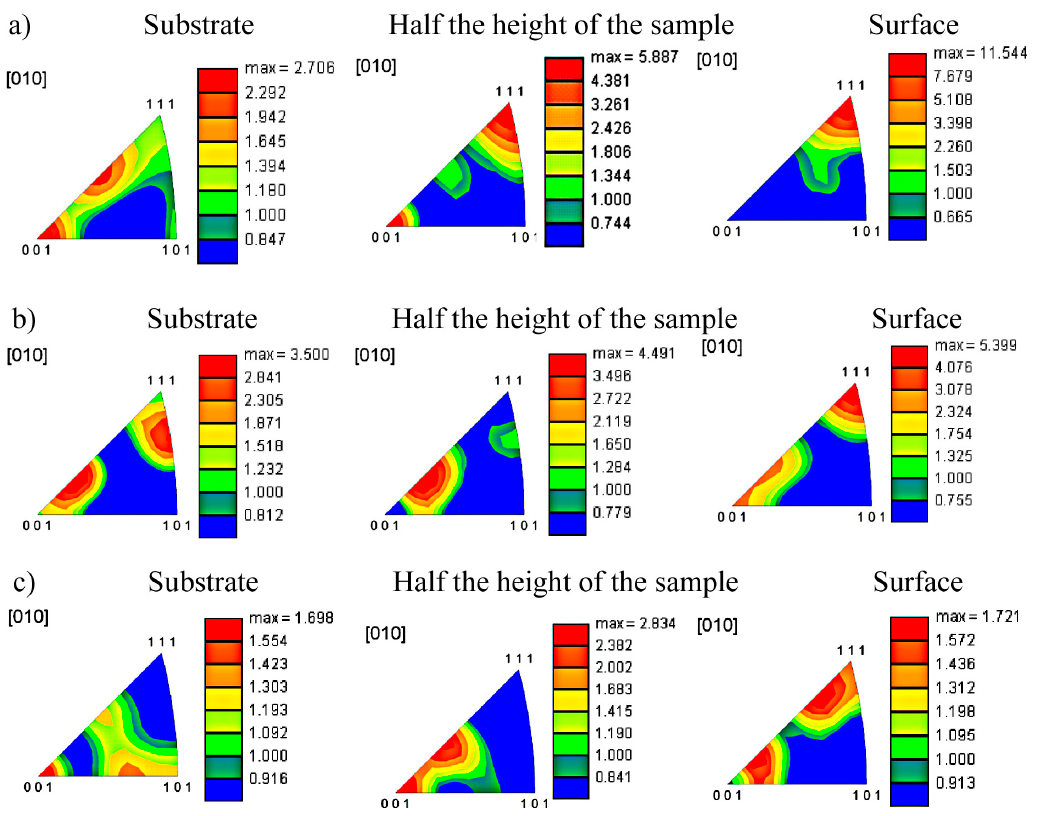
Figure 7. Inverse pole figures for samples made at ( a ) low (0.7, 0.6 and 0.6 × 10 4 K/s), ( b ) medium (2.1, 1.6 and 1.6 × 10 4 K/s), and ( c ) high (2.3, 3.5 and 2.6 × 10 4 K/s) cooling rates. 1.6 and 1.6 × 10 4 K/s), and ( c ) high (2.3, 3.5 and 2.6 × 10 4 K/s) cooling